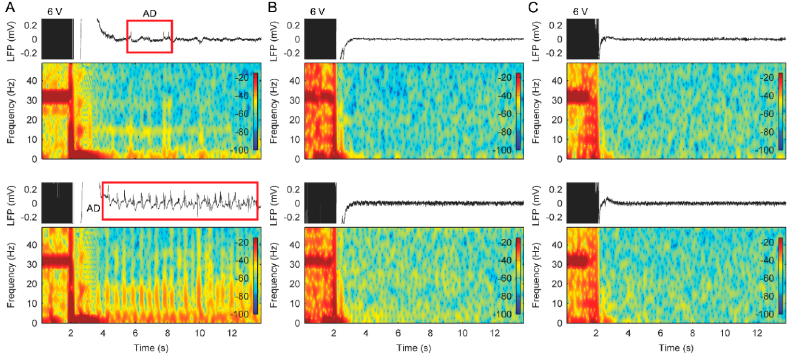
Figure 3. Effects of different unilateral stimulation amplitudes on the LFP recordings in the anterior cingulate cortex (ACC) from patient 1. ( A ) Bipolar LFP recordings and corresponding spectrograms from the left ACC during unilateral stimulation with increasing amplitudes. ( B ) Bipolar LFP recordings and corresponding spectrograms from the right ACC during unilateral stimulation with increasing amplitudes. Bottom panels show greater details illustrating several examples of after-discharges that occurred following cessation of stimulation.